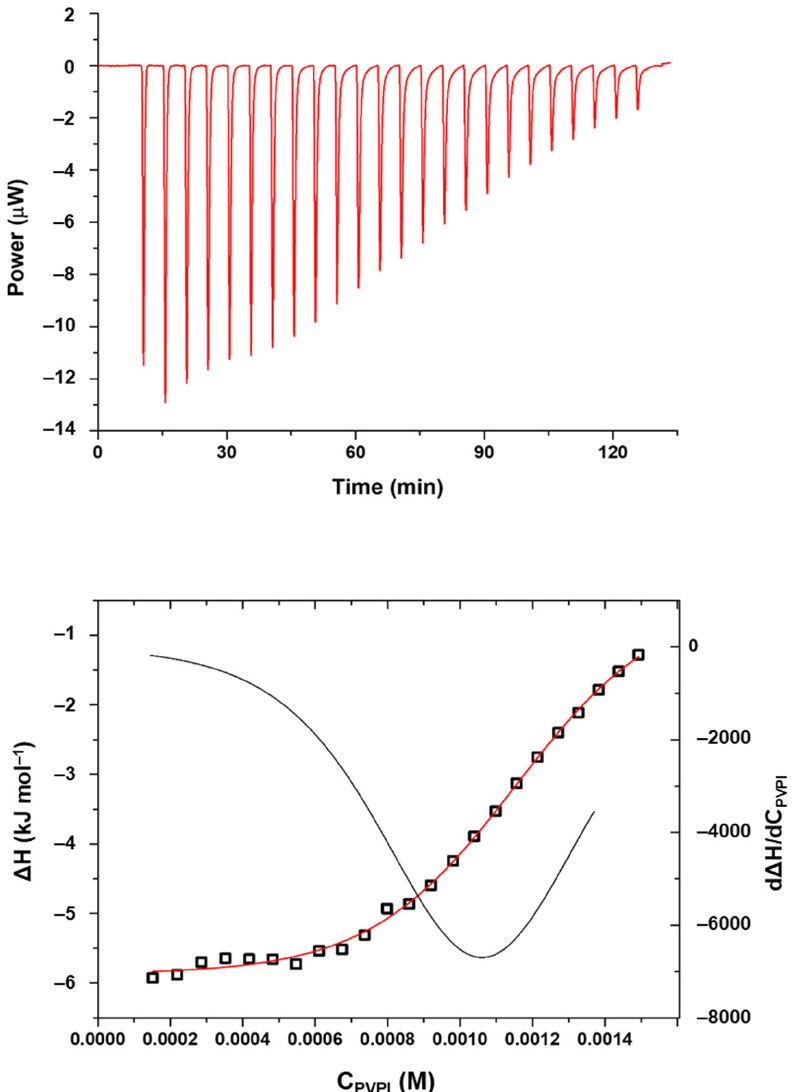
Figure 6. ITC titration of a 2.5 mg/mL PVPI solution into PCB at 25 °C ( top ); enthalpy of reaction as a function of the total concentration of PVPI in the calorimetric cell (C PVPI is calculated as the monomer unit; squares: enthalpy values, red line: curve fitting, black line: first derivative) ( bottom ).